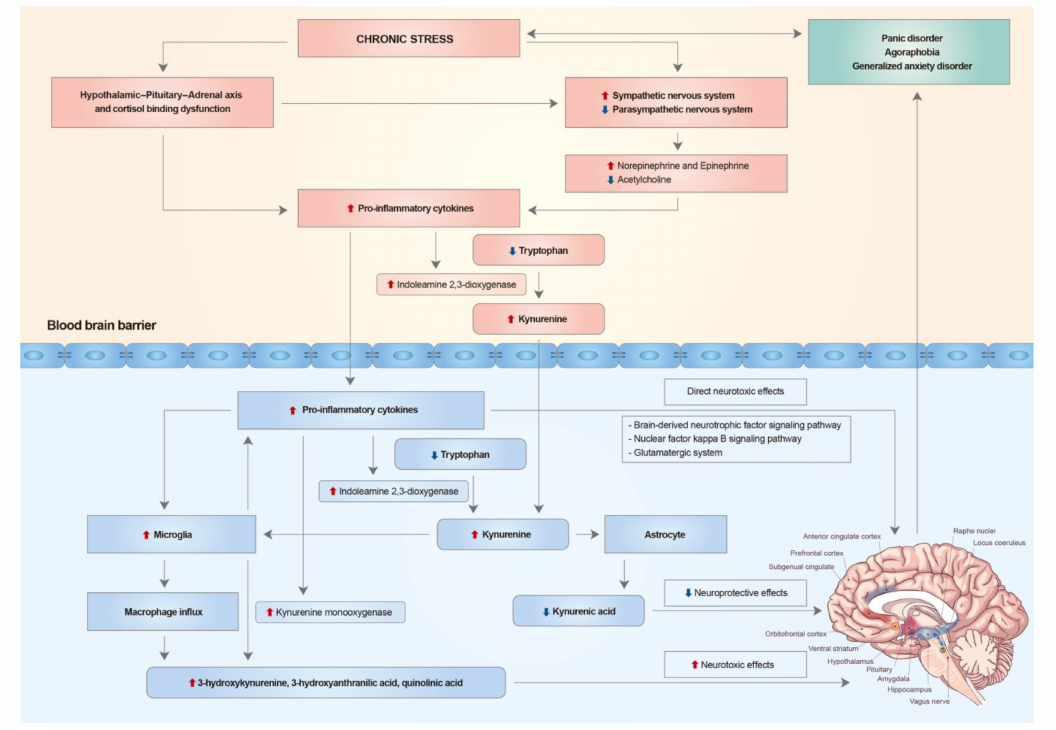
Figure 1. Chronic stress may lead to hypothalamic–pituitary–adrenal axis and autonomic nervous system disruption, which in turn may induce systemic proinflammatory conditions. Systemic inflammation leads to neuroinflammation, and enhanced levels of pro-inflammatory cytokines in the brain exert neurotoxic e ff ects on specific brain regions, either directly or secondarily through the kynurenine pathway. This may cause alterations in the structure or function of anxiety-related brain circuits, mainly limbic and pre-frontal structures, priming the brain to be vulnerable to anxiety disorders, such as panic disorder, agoraphobia and generalized anxiety